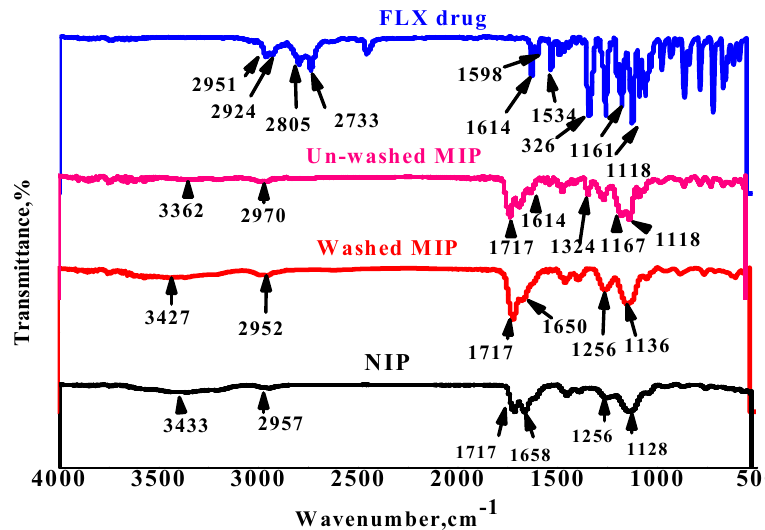
Figure 2. FT-IR spectra of fluvoxamine (FLX), FLV/MIP, washed molecular imprinting polymer (MIP) and non-imprinted polymer (NIP) beads.